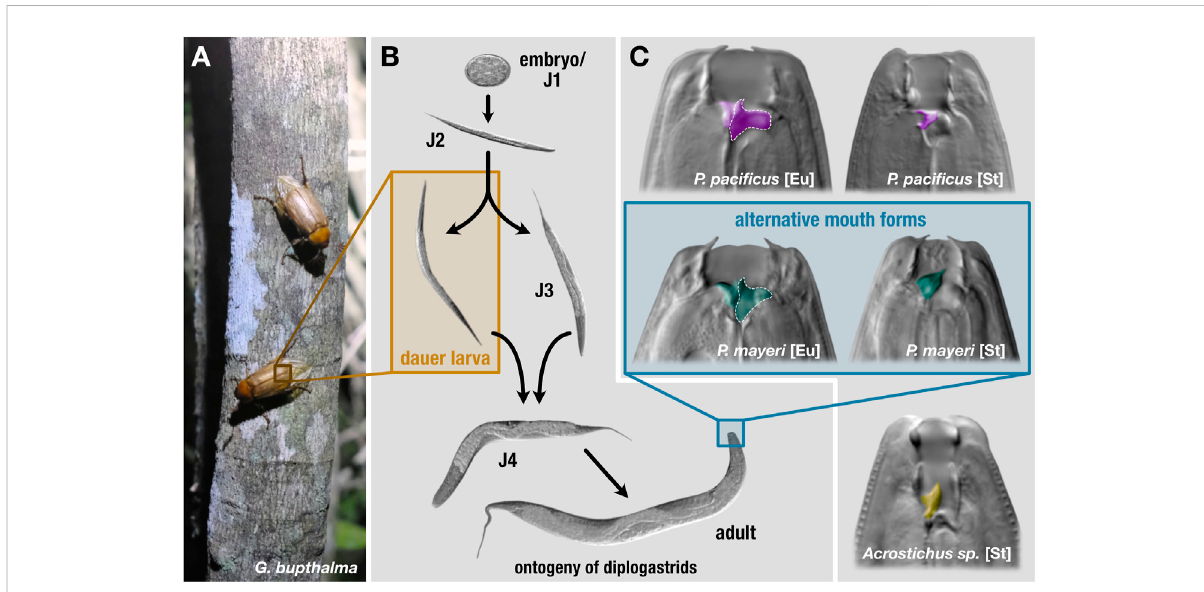
Lifecycle and mouth forms of three diplogastrids. On beetle hosts (A) , P. paci fi cus is found exclusively in the dauer stage. (B) Under favorable conditions, these nematodes develop from embryos to reproducing adults inroughly4 days. Inadverseenvironmentalsettings,young juveniles can enteranarresteddevelopmentalstage,dauer.Dauersaretriggeredtoexitinimprovedconditionsandresumedevelopment. (C) Themouthformsof the three diplogastrid species. Pristionchus paci fi cus and beetle-derived P. mayeri can develop either as bacterial-feeding stenostomatous (St) or predatory eurystomatous (Eu). Beetle-derived Acrostichus only developed as St. The teeth are colored by species. St worms only contain one tooth, the dorsal, while Eu have both the dorsal tooth and a subventral tooth, the latter of which is outlined in dotted white.